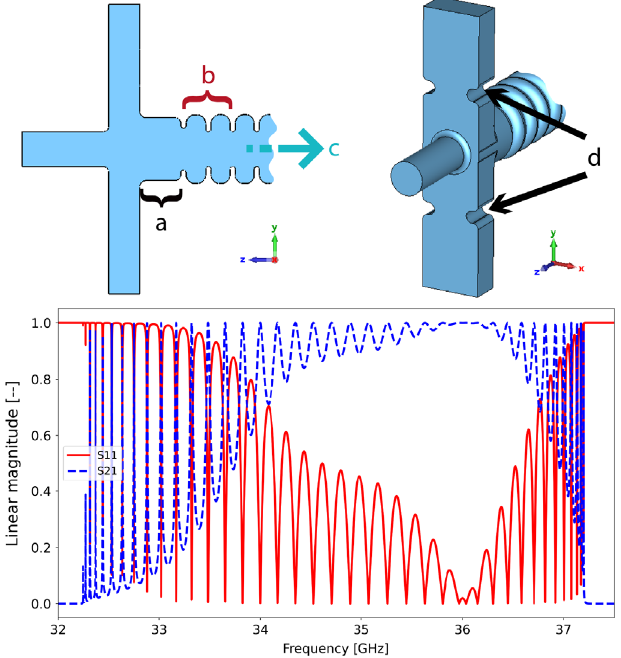
FIG. 15. Mode launcher geometry (top) and S-parameters for a 10-cm long structure (bottom).